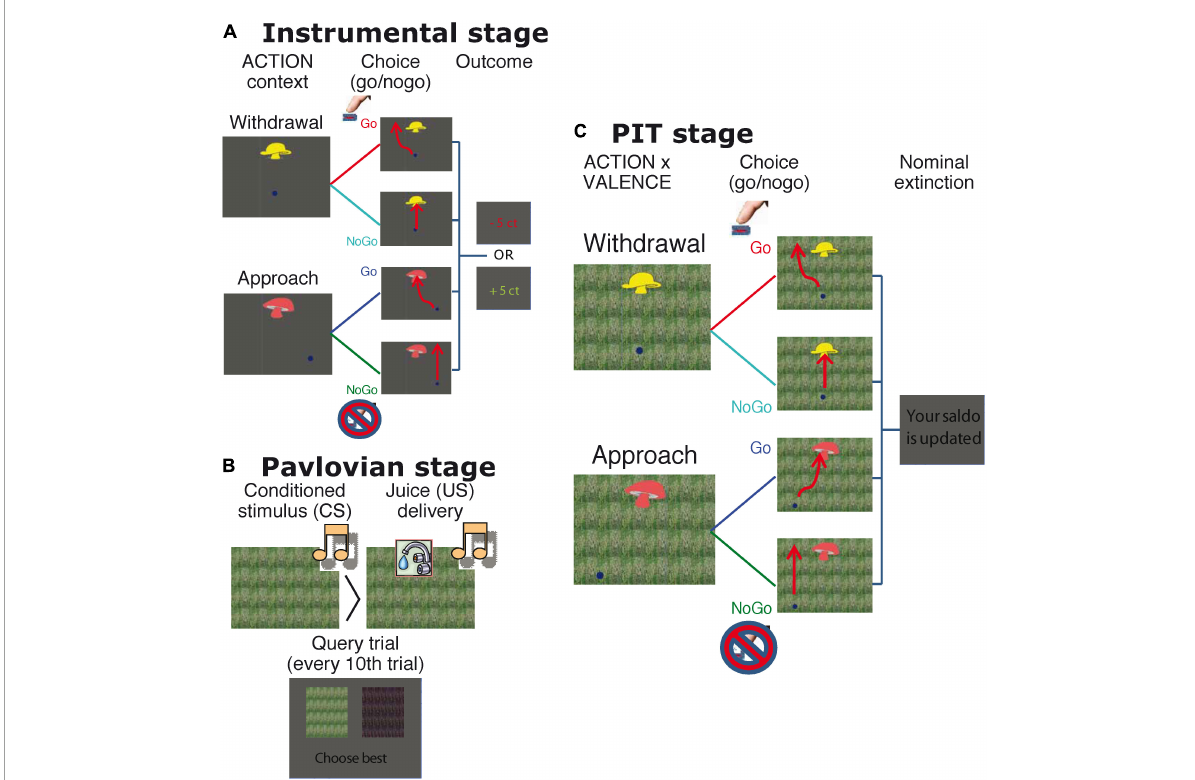
FIGURE1 Task details. (A) Instrumental stage. Trials started with the appearance of the instrumental stimulus at the top center of the screen and of a dot at the bottom of the screen. In approach trials, the dot started either on the left or on the right bottom side of the screen. Participants could choose to do nothing (approach-no-go), in which case the dot would wiggle past the instrumental stimulus. Alternatively, they could push the button repeatedly to steer the dot through the instrumental stimulus (approach-go). In withdrawal trials, the dot started centrally at the bottom beneath the instrumental stimulus. Participants could choose to push the button repeatedly to avoid moving through instrumental stimulus (withdrawal-go) or to do nothing (withdrawal-no-go). The four possible trajectories are drawn in the figure (red lines). If the dot entered the goal region, then the instrumental stimulus was collected. After the dot moved outside the window feedback was provided. Thus, there were 2 ACTION contexts (approach and withdrawal), with each 4 different instrumental stimuli, with 2 stimuli resulting more often in reward after a go-action and 2 resulting more often in reward after a no-go. Each stimulus was presented 10 times, resulting in (2 × 4 × 10=) 80 instrumental trials (divided in mini blocks of 8 withdrawal or approach trials). The straight line just to one side of the instrumental stimulus was a reflecting boundary that the dot could not cross. Timings were as follows: Instrumental stimuli were presented for 2.5 s, during which responses were collected. After 2.5 s, feedback was presented for 1 s. The intertrial interval (ITI) was 1 s (blank screen). (B) Pavlovian stage. Each